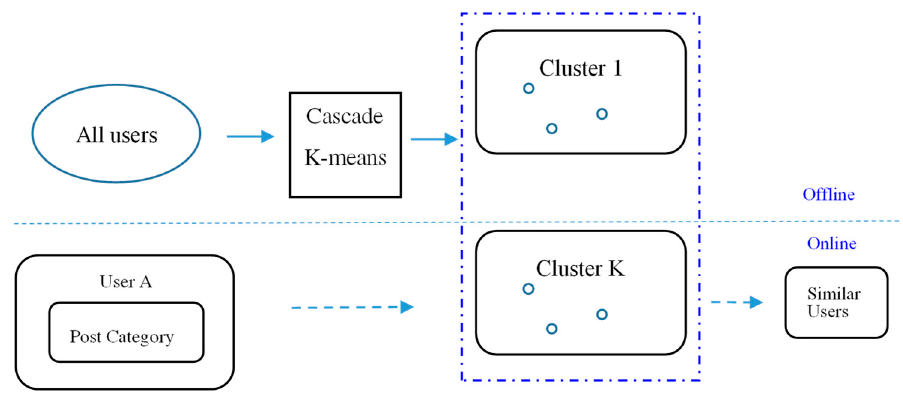
Figure 6. The architecture of recommendation based on user clustering.